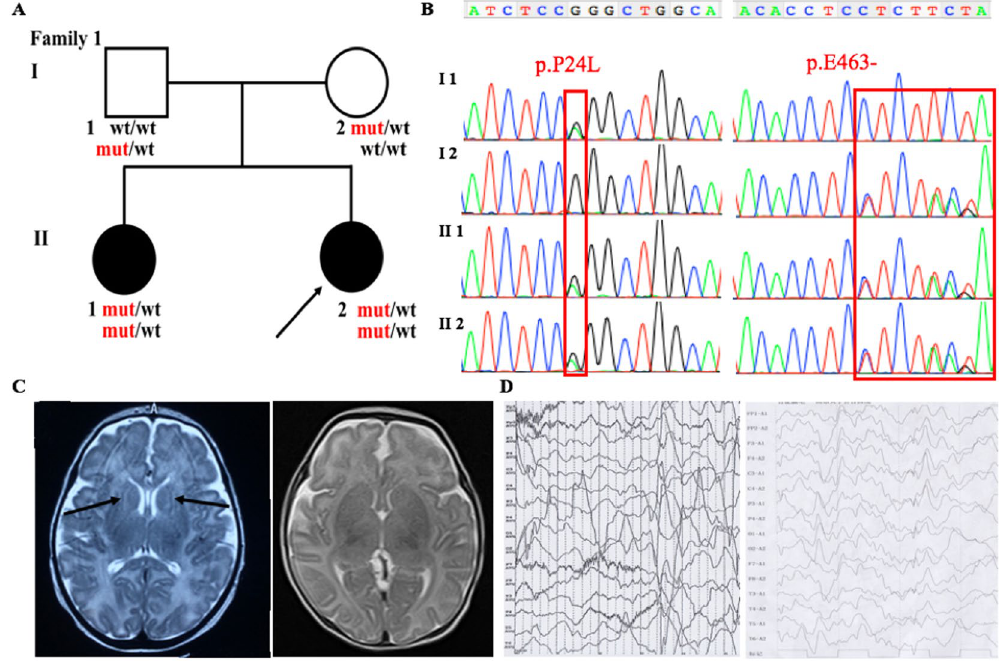
Figure 1. Clinical features of the patients and family 1 with the c.71 C > T, p.P24L; c.1387-1389delGAG, p.E463- in ADSL . ( A ) Pedigree structure of the studied family 1. In the family 1, WES was performed in I:1, I:2, II:2. Also, the compound heterozygous mutations were presented in the pedigree. ( B ) The PCR products were sequenced with the reverse primers ( ADSL c.71 C > T, p.P24L; c.1387-1389delGAG, p.E463-). ( C ) The brain MRI shows the abnormal myelination of white matter in the proband (1-month old) (Left), and normal signal of the II 1 (Right) with T2-weighted. ( D ) EEG of the patients show the abnormal multifocal spike and ware wave in the proband (Left) and II 2 (Right).